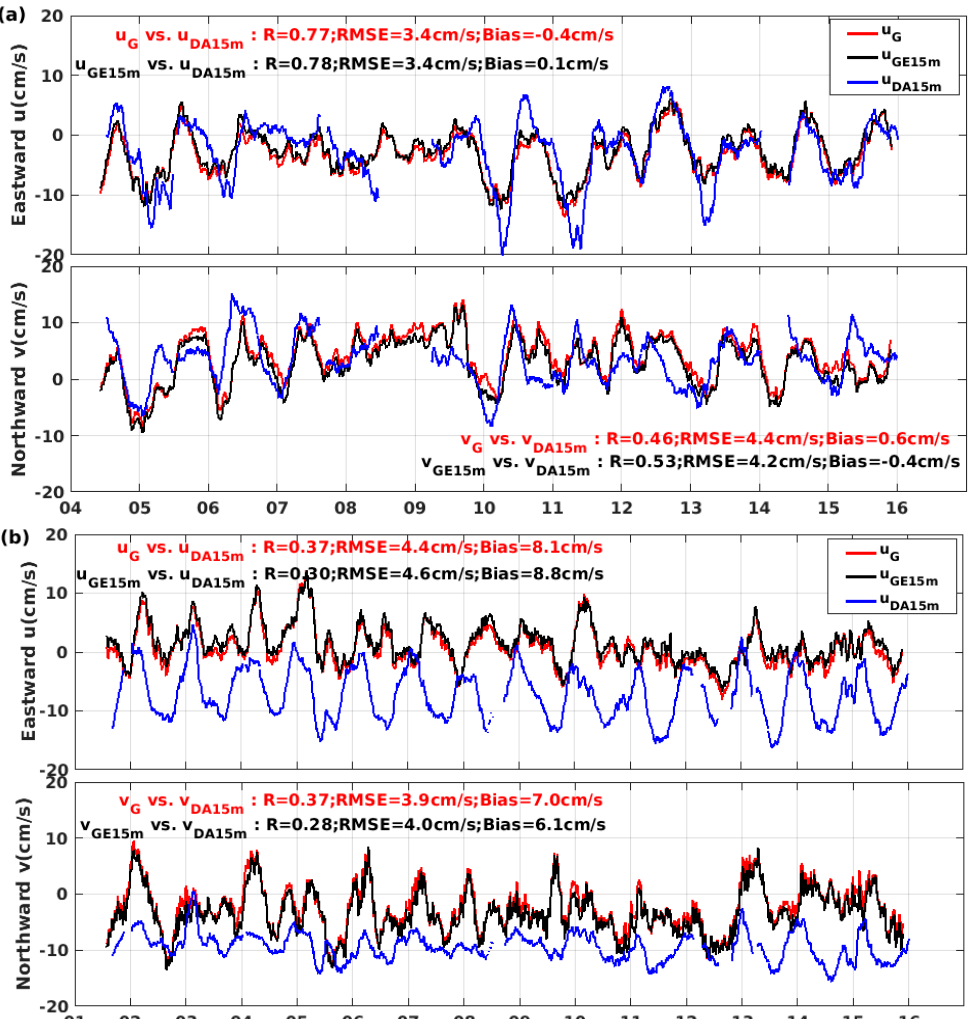
Figure 4. ( a ) GoM Buoy-N low-passed (70-day running mean applied) time series of current components of GC U G (Geostrophic) and U GE15 m (Geostrophic + 15 m Ekman) as well as ADCP depth- averaged (10–20 m) U DA15 m with upper and lower panels representing eastward u and northward v current components. Each panel provides statistical measures for U G vs. U DA15m (red text) and for U GE15m vs. U DA15m (black text). ( b ) Buoy-I low-passed time series in the same format.